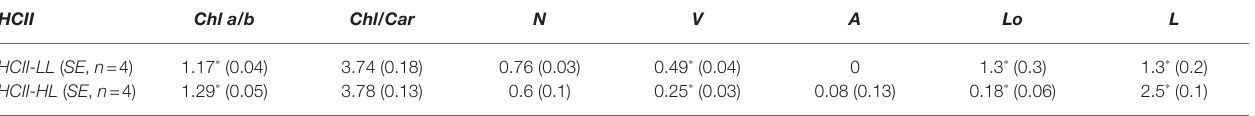
Xanthophyll content is normalized to 14 Chls (a + b) molecules to indicate the xanthophylls per monomer in the trimeric complex. Chlorophylls (Chl) a/b and Chl/Car are expressed in mol/ mol. n indicates the number of biological replicates. N, Neoxanthin; V, Violaxanthin; A, Antheraxanthin; Lo, Loroxanthin; and L, Lutein. * The means are significantly different p <